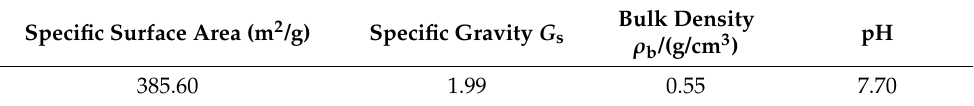
Table 2. Main physical indexes of